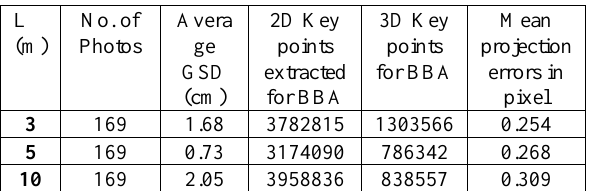
Table 1. The outcome of three Different Surveys to determine a Practical Base Line to the Cliff